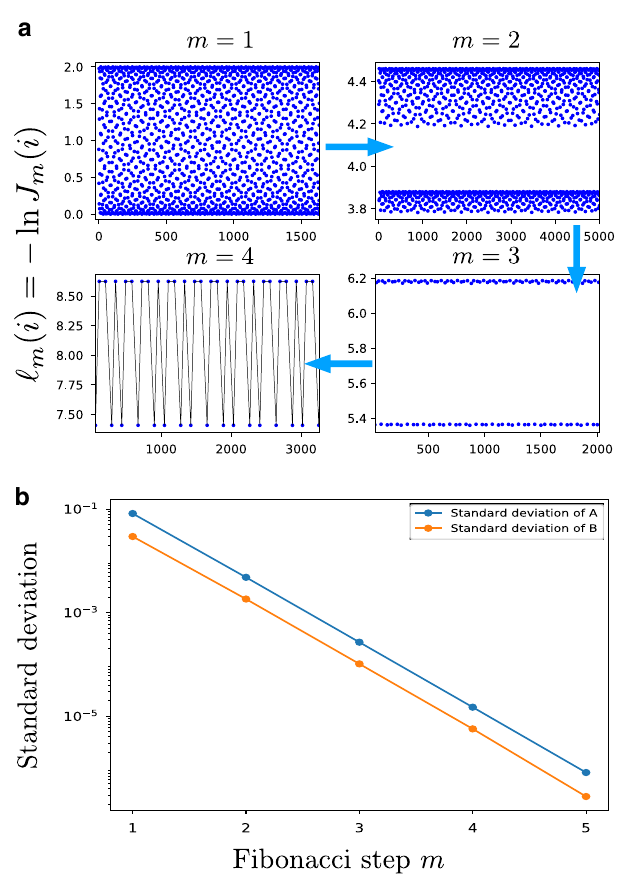
Fig. 1 Quasiperiodic Heisenberg chain. a Evolution of the couplings under renormalization for an Heisenberg chain with initial potential (3) with a = 1. The fl uctuations decay with the number of RG steps and become completely negligible after a few Fibonacci steps. b The fl uctuations about the sequence prediction (4) starting from a cosine potential decay exponentially with the number of Fibonacci RG steps m